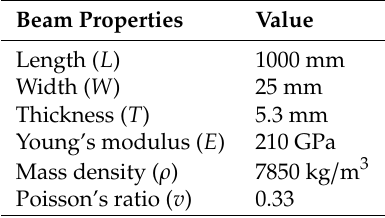
Table 1. Beam dimensions and steel properties.